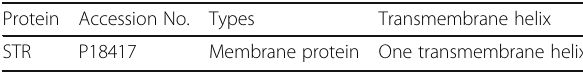
Table 3 Transmembrane regions identified by SOSUI server Protein Accession No. Types